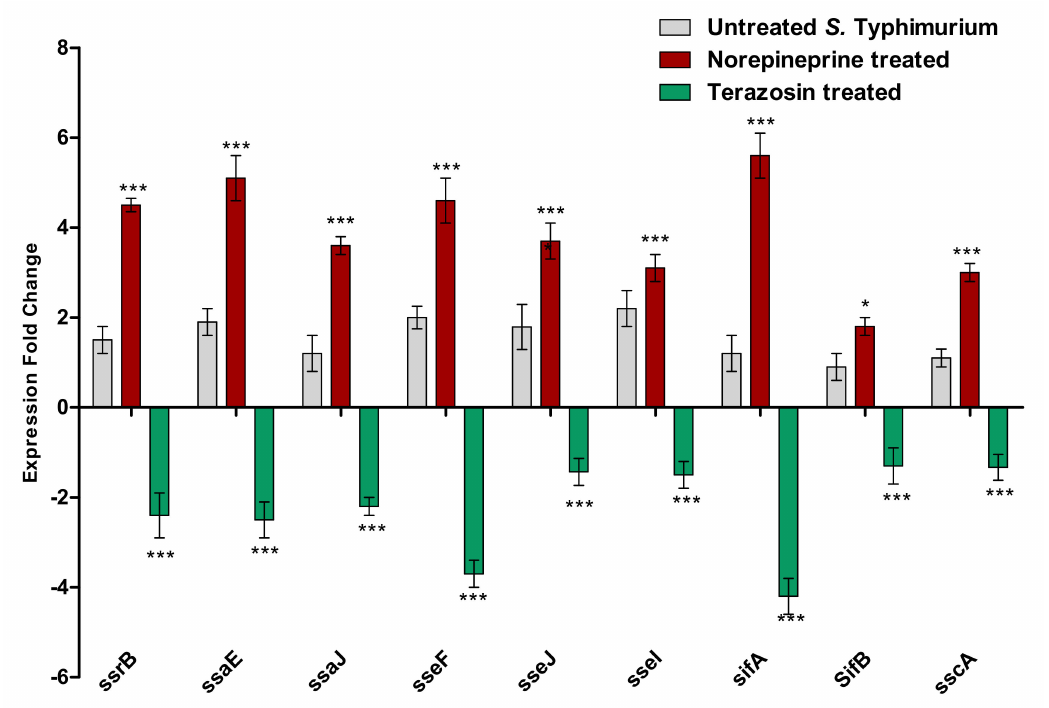
Figure 9. Terazosin down–regulated the T3SS encoding gene expression. Terazosin at the sub–MIC reduced significantly the expression of T3SS encoding genes. However, norepinephrine up–regulated the expression of the tested genes. The experiment was repeated in triplicate, and the data are presented as the mean ± the SD. A two-way ANOVA test, followed by a Bonferroni post-hoc test, was used to attest the statistical significance; p < 0.05 was considered significant. *** = p < 0.0001; * = p <